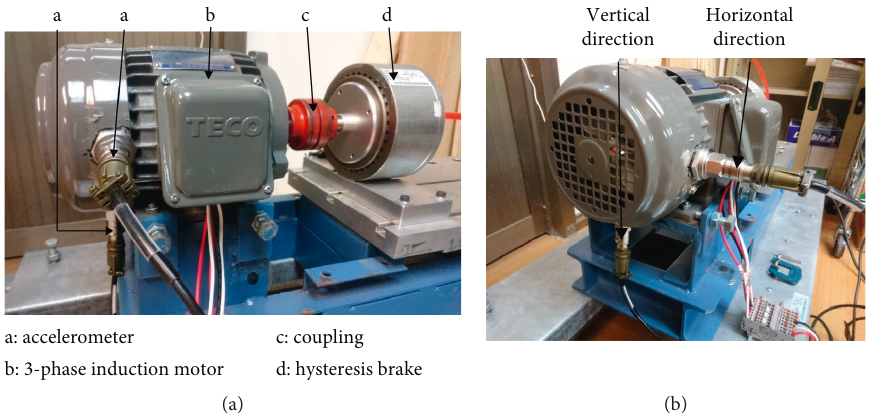
Figure 3: (a) Setup of the motor-driven rotary system. (b) Installation of accelerometers. a: accelerometer; b: 3-phase induction motor; c: coupling; d: hysteresis